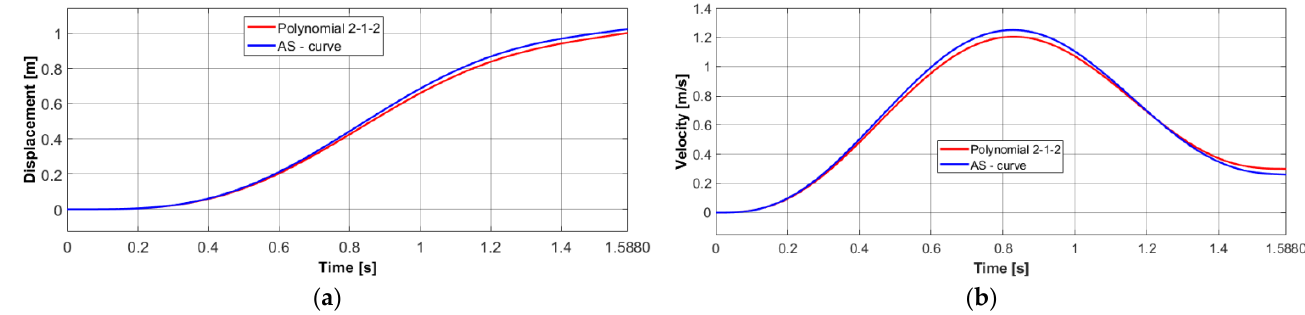
Figure 6. Profile of the polynomial 2-1-2 jerk and profile of the AS-curve with the denoted charac- teristic quantities.